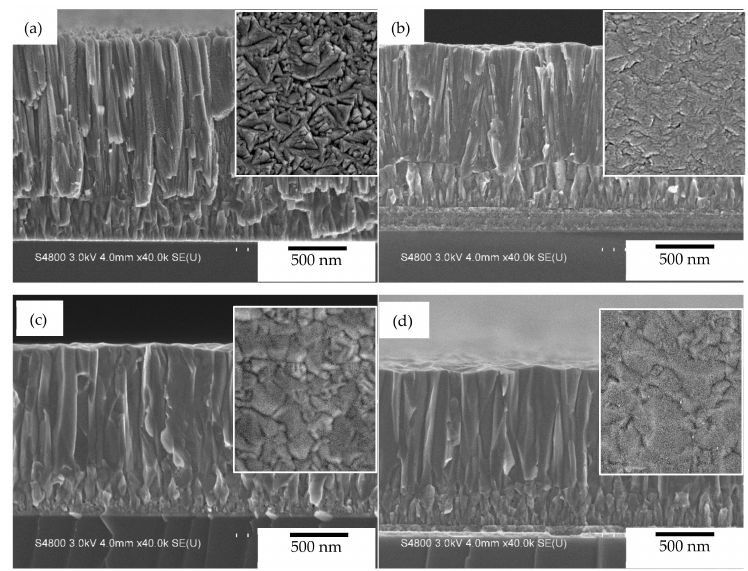
Figure 5. Cross-sectional and top (right upper corner) SE micrographs of Cr films deposited at pressure of 0.8 Pa with ( a ) HiPIMS pulse width 60 µ s / pulsed substrate bias 0 V; ( b ) HiPIMS pulse width 200 µ s / pulsed substrate bias 0 V; ( c ) HiPIMS pulse width 60 µ s / pulsed substrate bias − 200 V; and ( d ) HiPIMS pulse width 200 µ s / pulsed substrate bias − 200 V.